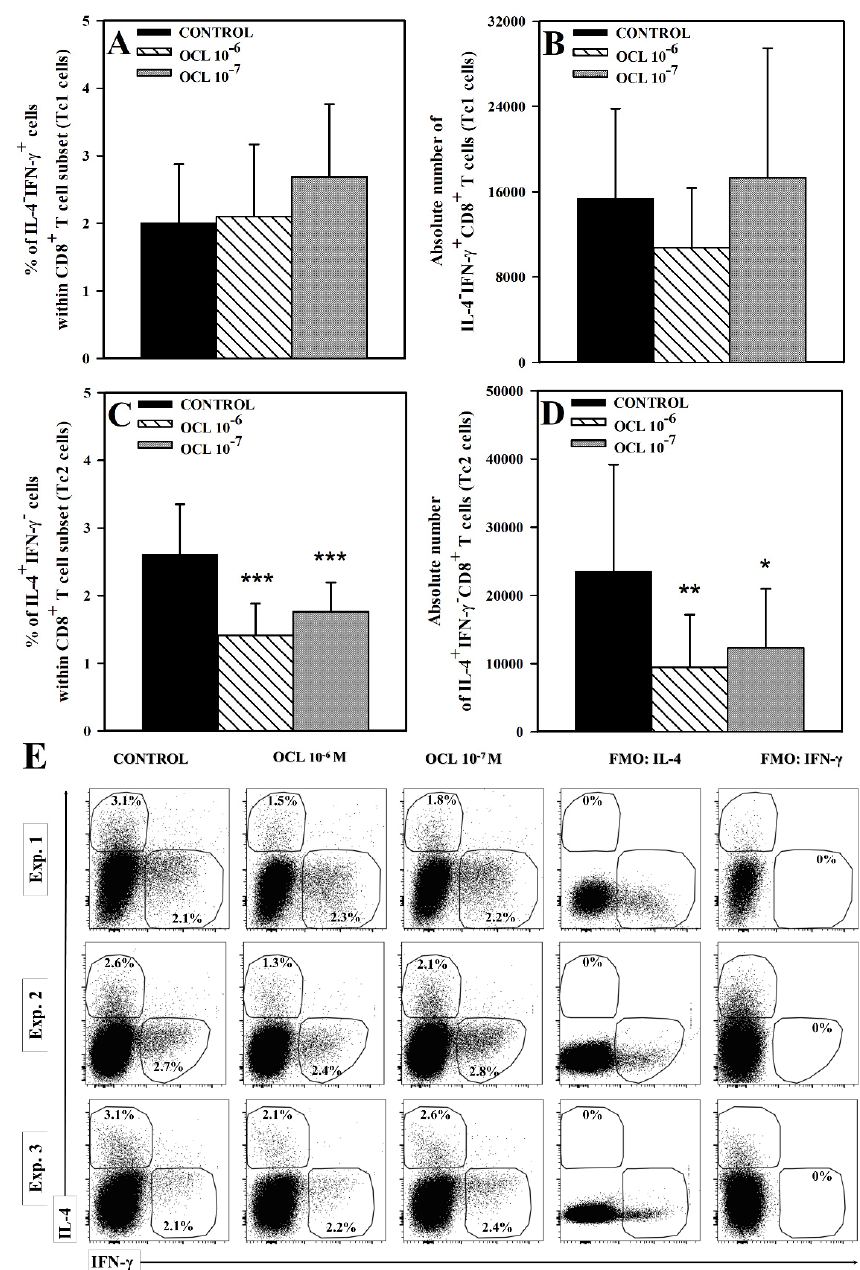
Figure 2. Effect of oclacitinib (OCL) on the number of IFN- γ - and IL-4-producing CD8 + T cells. The relative ( A , C ) and absolute count ( B , D ) of IFN- γ - and IL-4-producing CD8 + T cells were determined in cell cultures incubated with or without (control) OCL (10 − 6 M and 10 − 7 M). The relative count is expressed as a percentage of IFN- γ - or IL-4- producing cells within